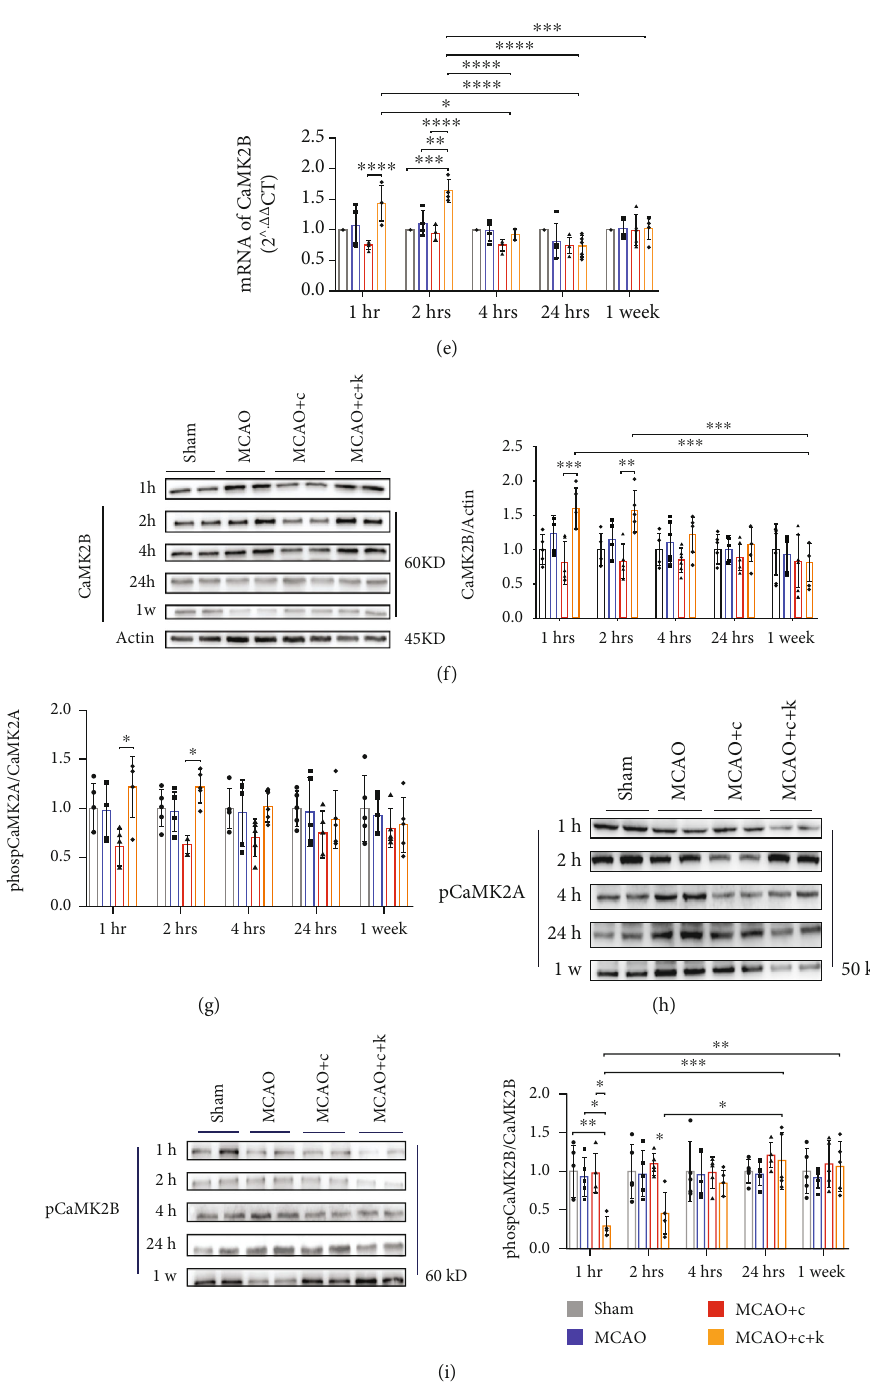
Figure 3: Changes in NMDAR and CaMKII subunits after ketamine administration. (a) Representative immunoblots and NMDAR2- α (NR2A or NMDAR2A) expressions in the hippocampal DG of various study subjects. (b) Representative immunoblots and NMDAR2- β (NR2B or NMDAR2B) expressions in the hippocampal DG of various groups after ketamine. (c) Relative mRNA expression of CaMK2A in the hippocampal DG region of the brain. (d) Representative immunoblots and protein expression of CaMK2A in the DG region of various test subjects. (e) Relative mRNA expression of CaMK2B in the hippocampal DG region of various study groups. (f) Representative immunoblots and protein expression of CaMK2B in the hippocampal DG region of the brain. (g) Protein levels of the phosphorylated state of CaMK2A (pCaMK2A or phospCaMK2A) in di ff erent groups. (h) Representative immunoblots of pCaMK2A expressions. (i) Representative immunoblots and protein levels of the phosphorylated state of CaMK2B (pCaMK2B or phospCaMK2B) in the GD region of various experimental subjects. 1w =1 week. MCAO+c: MCAO+CUMS; MCAO+c+k: MCAO+CUMS+ketamine. One-way ANOVA followed by Tukey ’ s multiple comparison tests. n = 6 per group. ∗ p < 005 , ∗∗ p < 0 : 005 , ∗∗∗ p < 0 : 0005 , and ∗∗∗∗ p < 0 : 0001